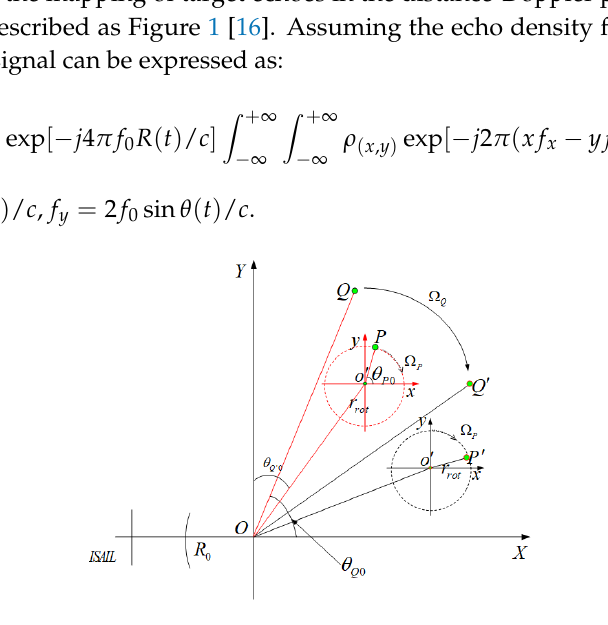
Figure 1. ISAIL geometric